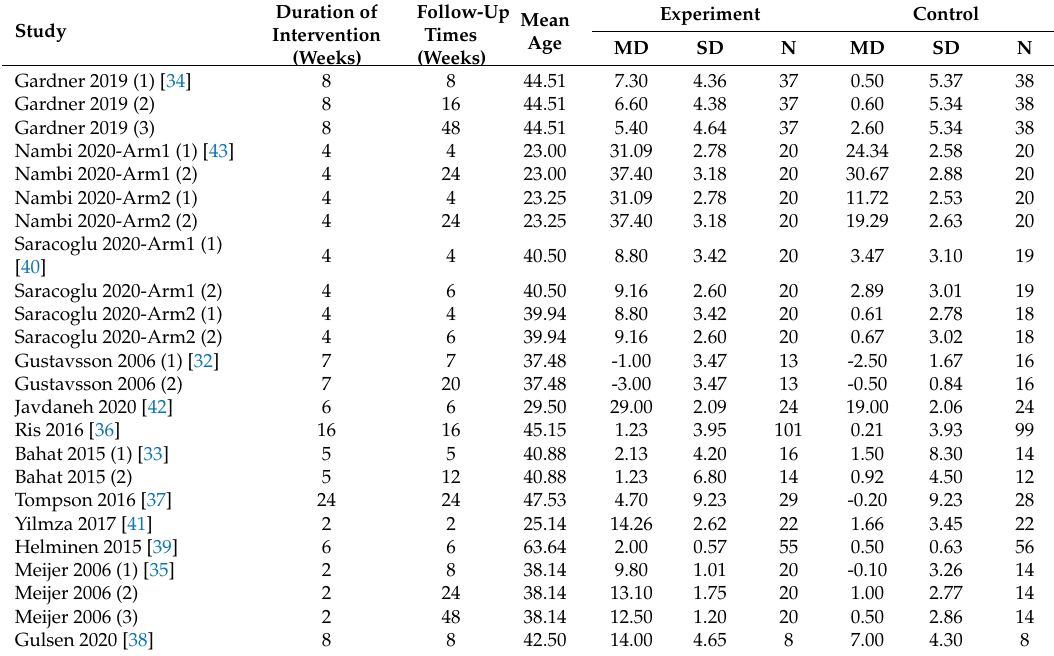
Table 3. The result of original data processing.